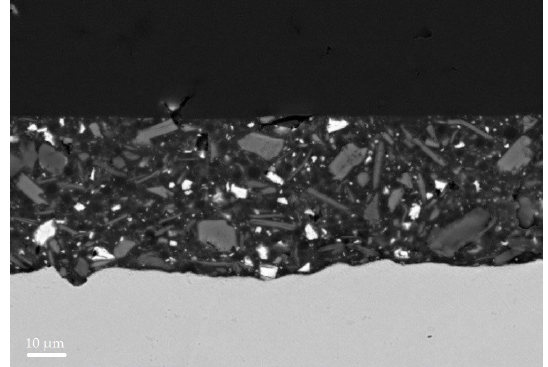
Figure 12. S6 coating; section before HT. Homogeneous distribution of fillers.